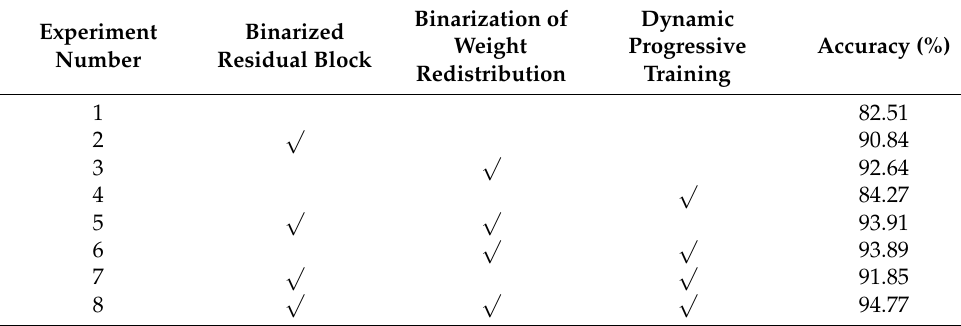
Table 6. Comparison of ablation experiment Settings and corresponding accuracy.